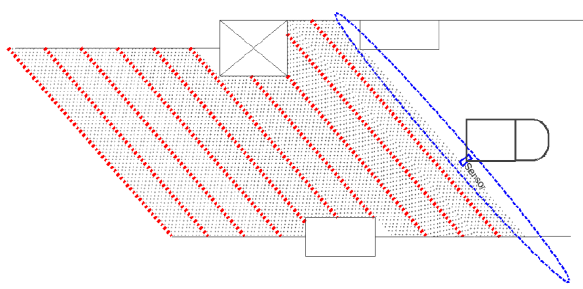
Figure 3. GPS time interval.